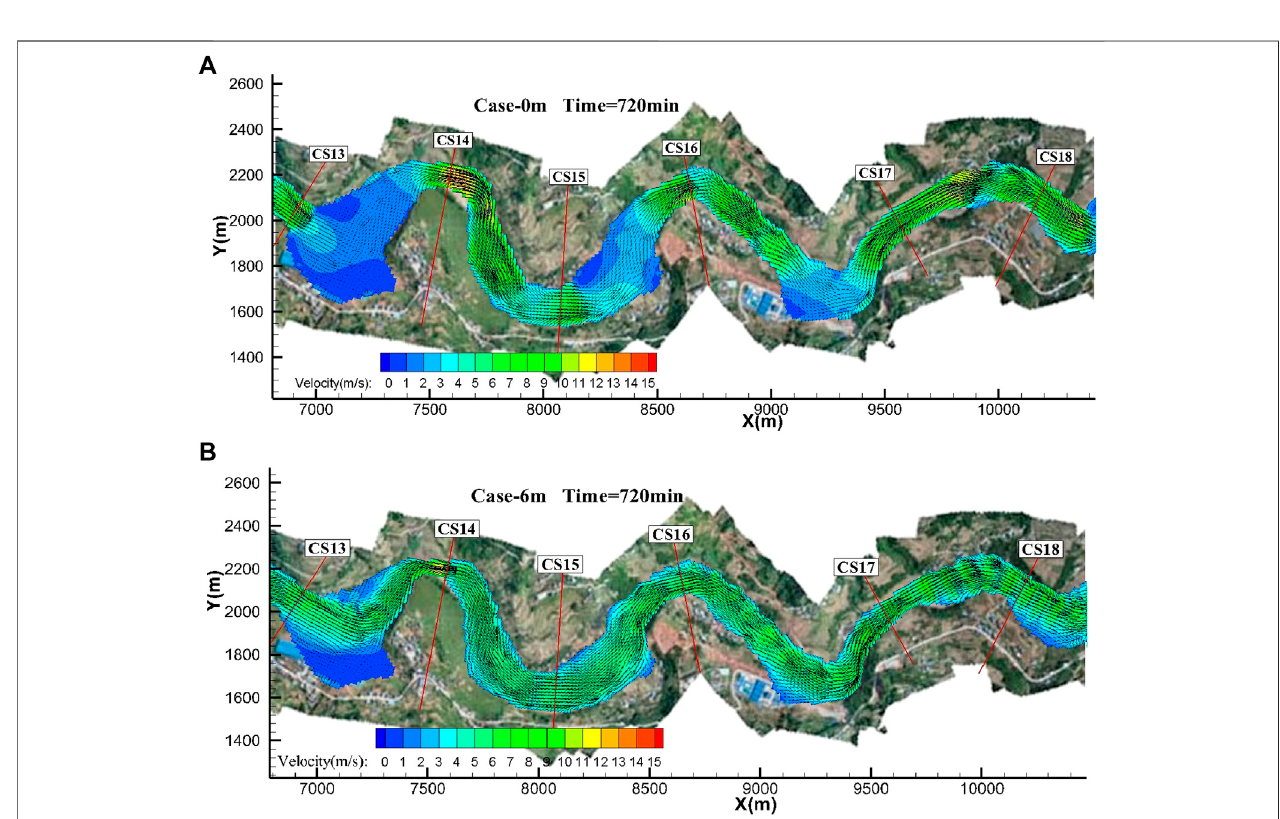
FIGURE 11 | Velocity and depth distribution downstream the Zhongdu Town in case-0m (A) and case-6m (B) .